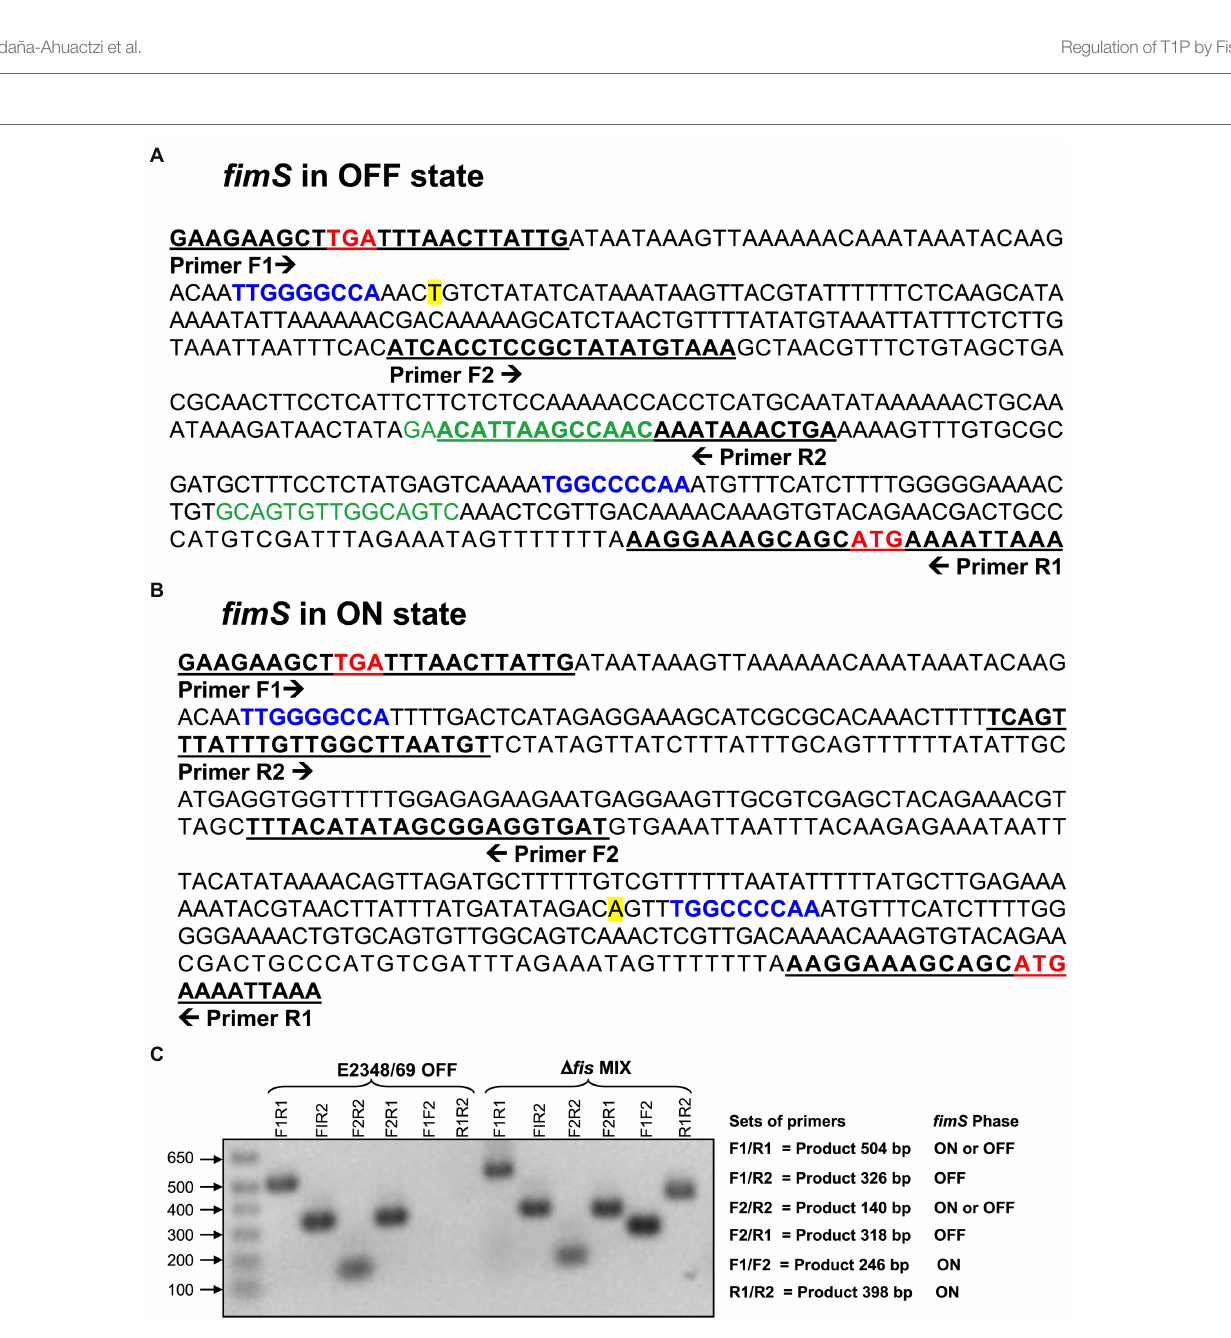
FIGURE 4 | Orientation of the fimS invertible element in EPEC strains. (A) The nucleotide sequence of the region upstream of the fimA structural gene in E2348/69 (Abraham et al., 1985; Klemm, 1986) contains the fimS invertible element locked in the OFF orientation. Putative Fis-binding sites are denoted in green. (B) Sequence of the fimS switch oriented in the ON position. The stop codon (TGA) of fimE and the start codon (ATG) of fimA are denoted in bold red. The inverted repeat (IR) sequences, IRL (left) and IRR (right), are indicated in blue. The transcription start [A] of the fimA promoter is highlighted in yellow. The underlined nucleotide sequences show the binding sites of the primers used in the PCR reaction and the arrows indicate the direction of each primer. (C) PCR with different sets of primers show that the Δ fis mutant is a mixture of cells containing the fimS invertible element oriented in either ON or OFF position. In contrast, the fimS switch in the E2348/69 is oriented in the OFF position. The set of primers used, products expected, and the fimS phase for each set of primers used are shown on the